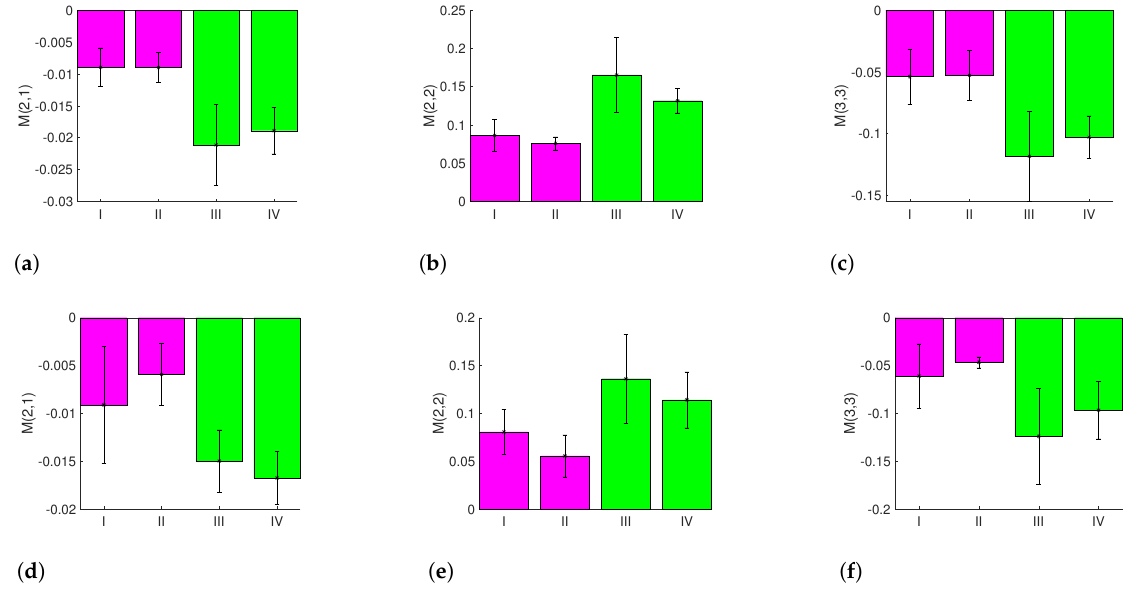
Figure 6. MM entries for different regions of interest with an observable difference between the measurements with and without riboflavin: ( a ) mean value of M ( 2,1 ) using the blue area; ( b ) mean value of M ( 2,2 ) using the blue area; ( c ) mean value of M ( 3,3 ) using the blue area; ( d ) mean value of M ( 2,1 ) using the red area; ( e ) mean value of M ( 2,2 ) using the red area; and ( f ) mean value of M ( 3,3 ) using the red